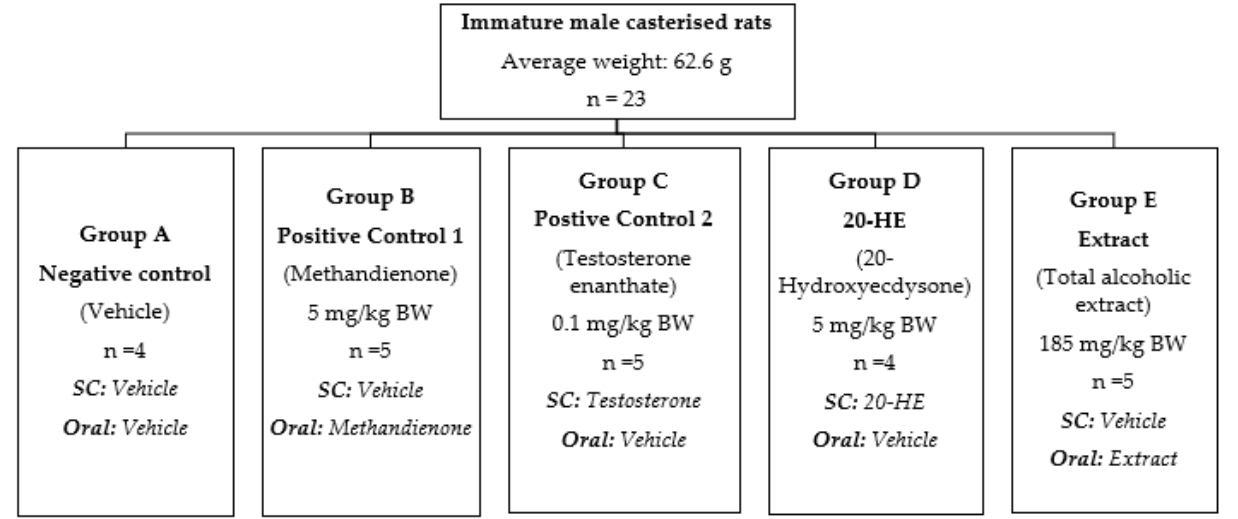
Figure 16. The scheme of experimental design for the study of the effect of 20-HE and total alcoholic extract on muscle fibers and secondary sex organs.